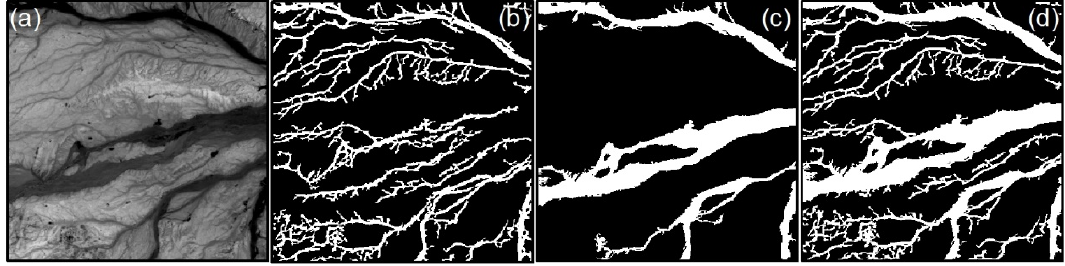
Figure 7. ( a ) NWI image; ( b ) extraction results for small wadis; ( c ) extraction results for wide wadis; ( d ) the final wadi extraction results. ( d ) the final wadi extraction